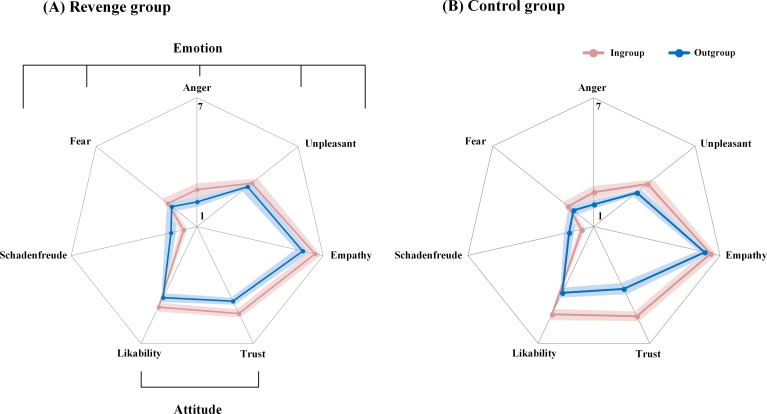
Illustration of behavioral results.(A) The results of attitude and emotion ratings (from 1 to 7) related to ingroup and outgroup targets in the Revenge group. (B) The results of attitude and emotion ratings (from 1 to 7) related to ingroup and outgroup targets in the Control group.